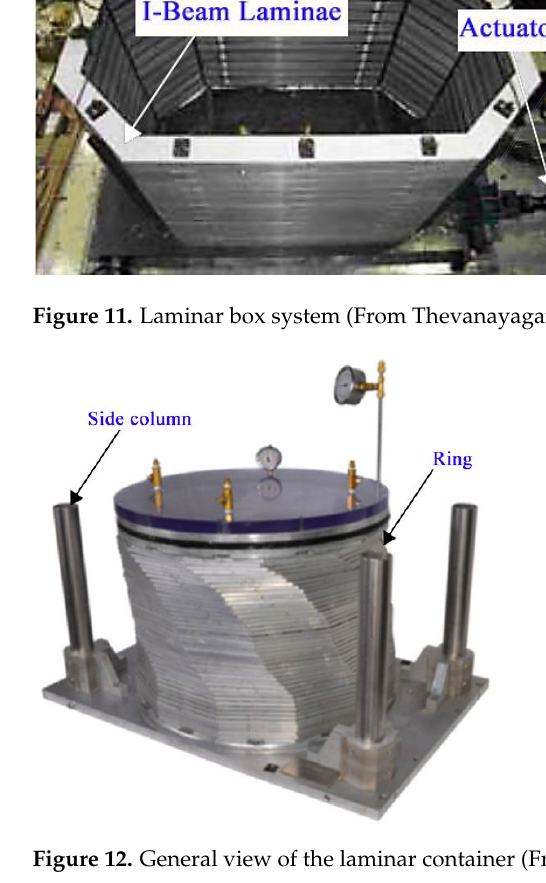
Figure 11. Laminar box system (From Thevanayagam et al. [57]; modified).